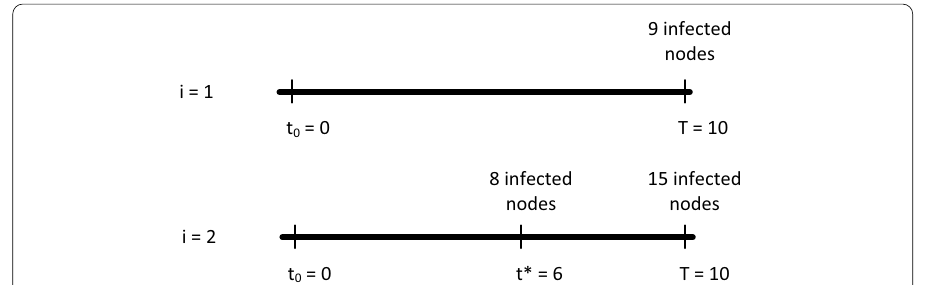
Fig. 1 Two outbreak scenarios. In the first scenario ( i = 1 ), the outbreak is not detected by S . The penalties for the DT, PA, and DL objectives are 10, 9, and 1, respectively. Obviously, the penalty reductions will be 0 for all three objectives. In the second scenario ( i = 2 ), the outbreak is detected at t ∗ = 6 and the penalties are 6, 8, and 0. The corresponding penalty reductions are 4, 7, and